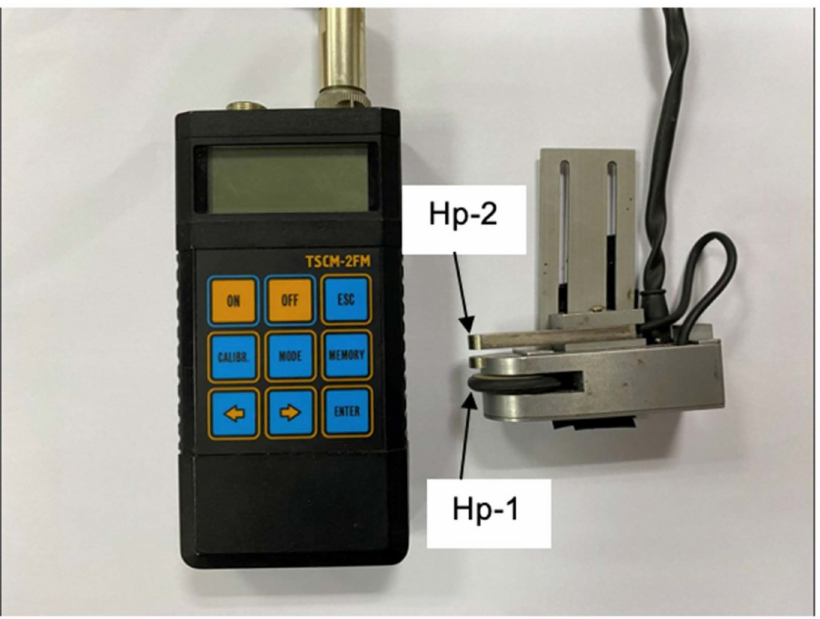
Figure 4. Tester of stress concentration